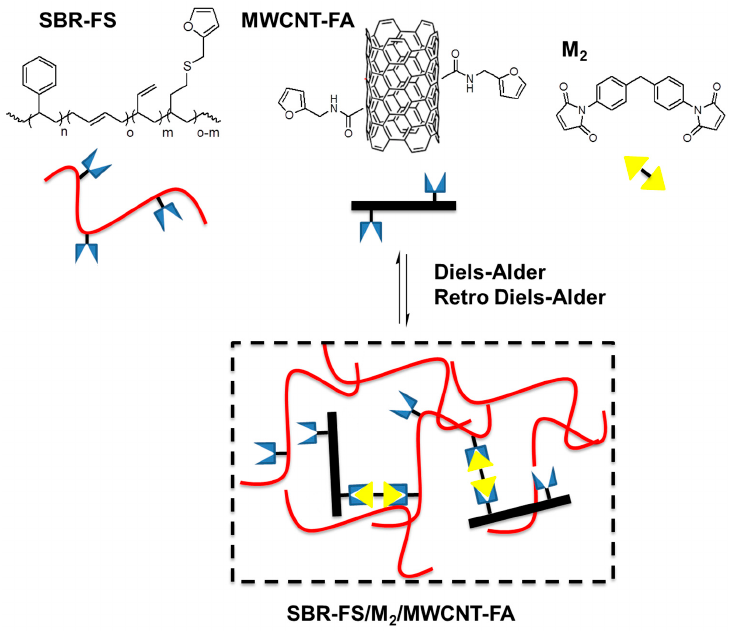
Figure 5. Synthesis of covalently bonded and reversibly cross-linked rubber nanocomposites via Diels–Alder reaction. Adapted with permission from [103]. Copyright © 2016 by WILEY-VCH Verlag GmbH & Co.